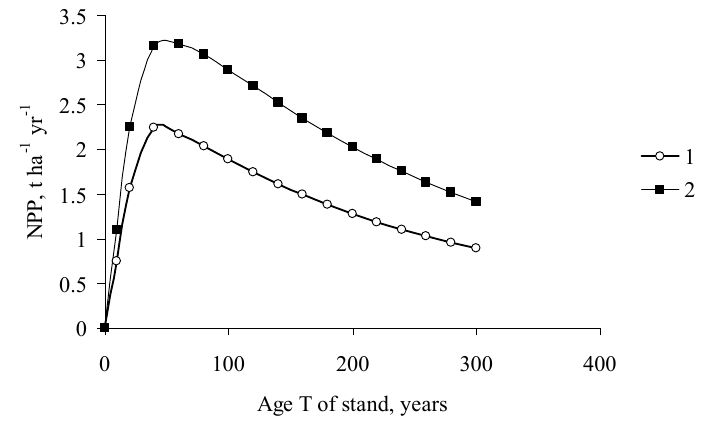
Figure 4. Age dynamics of the NPP of single-species even-aged pine stands ( 1 ) South Siberia, ( 2 ) Middle Siberia).